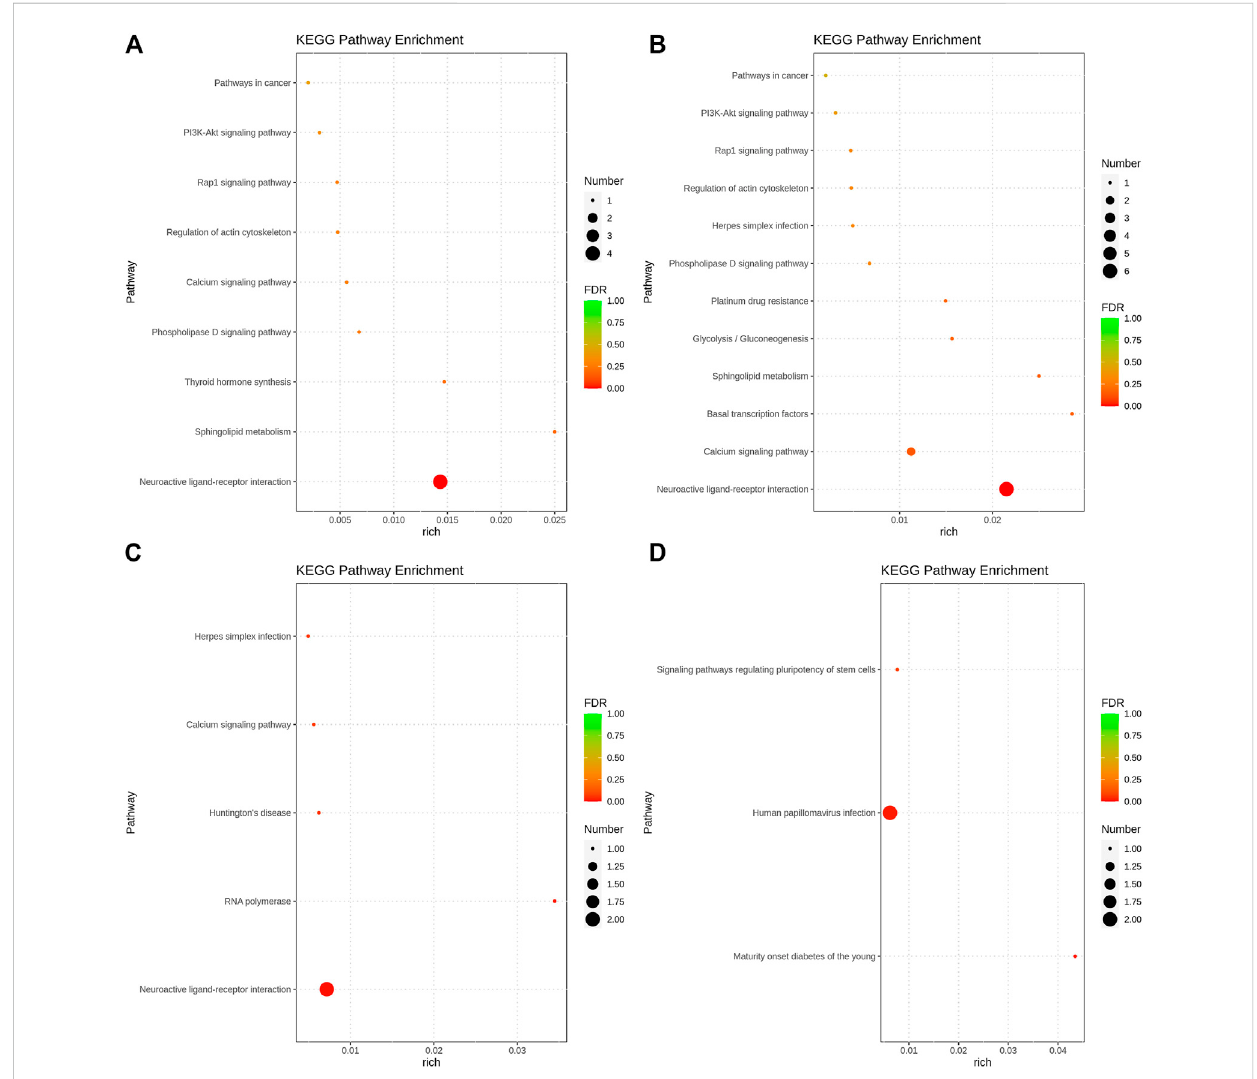
FIGURE 5 Bubble chart of KEGG pathway analysis results. (A) . Body height, (B) . Body length, (C) . Chest circumference, (D) . Shin